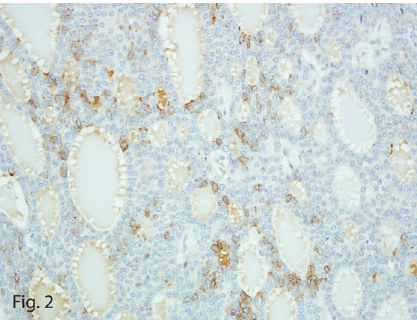
Figure 2: Chromogranin immunostain with focal expression in the tumor (original magnification × 40).